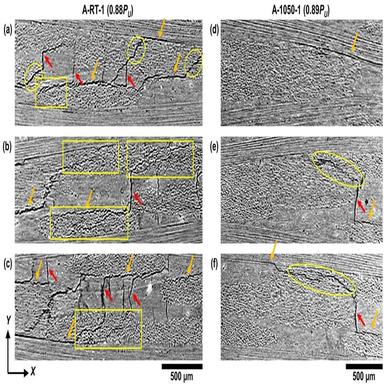
(a)-(c) Fracture patterns in material A at RT (A-RT-1) and (d)-(f) at 1050 C (A-1050-1). Orange arrows indicate Type I interfacial cracks; yellow circles marking Type II inclined intra-tow cracks; red arrow Type III matrix cracks and yellow rectangle microcracks (parallel cracks or bifurcation). Note: the area investigated for specimen A-RT-1 was in the middle of the specimen on the left-hand side of the DVC field of view presented in This area was also highlighted in using a open da